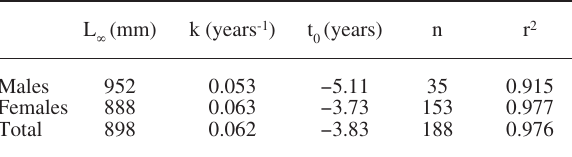
Table 3. – Von Bertalanffy growth parameters for males, females and all fish of Mycteroperca fusca off the canary Islands. l (mm) k (years -1 ) t ∞